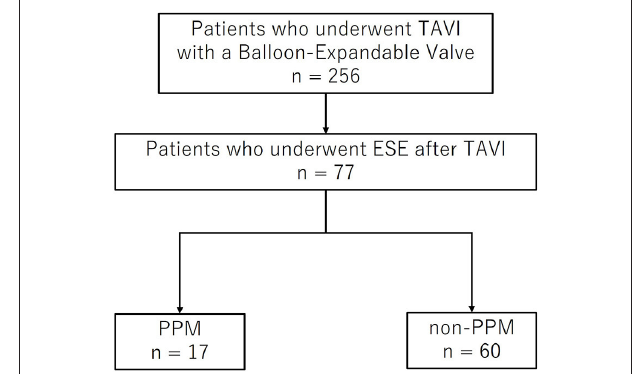
FIGURE 1 | Flow diagram of patient recruitment. TAVI, transcatheter aortic valve implantation; ESE, exercise stress echocardiography; PPM, prosthesis-patient